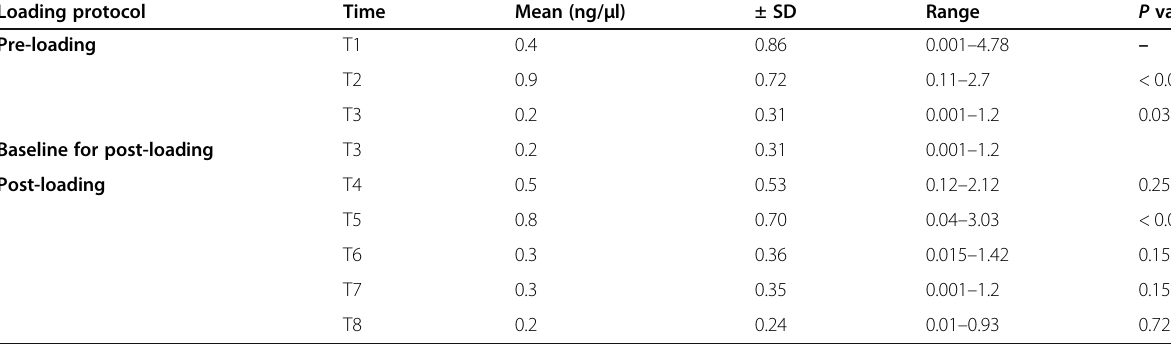
Table 2 Quantitative levels of cfNAs in PMICF in combined all four quadrants before and after loading of MSI